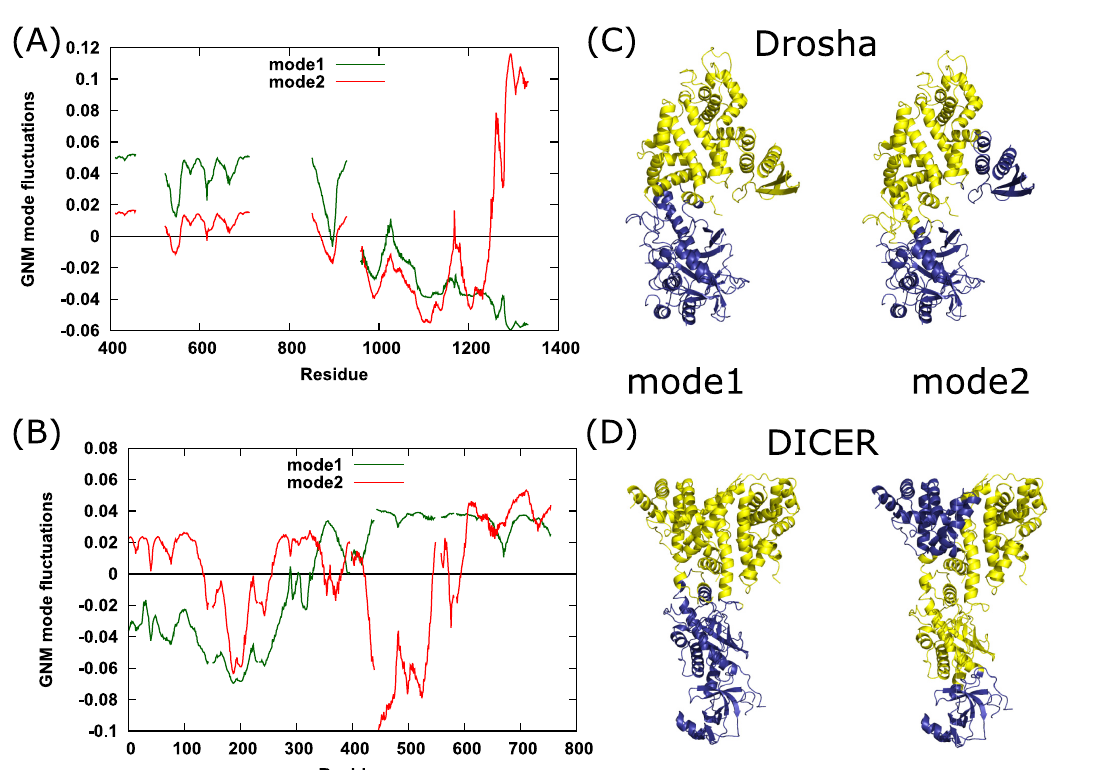
Fig 3. GNM first and second slow modes. Fluctuation values of the GNM first (green) and second (red) slowest modes of (A) Drosha and (B) Dicer. Residues with opposite signs are moving in anti-correlated manner and high (low) absolute fluctuation values indicate high (low) mobility. Residues at the crossover between positive and negative fluctuations act as hinges in the movement of the proteins. (C) Drosha and (D) Dicer structures colored according to the positive and negative signs of the first and second GNM slowest